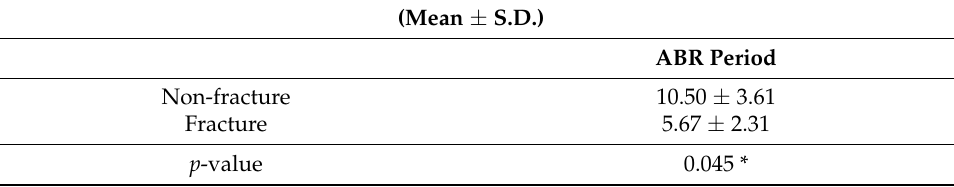
Table 7. Comparisons of ABR